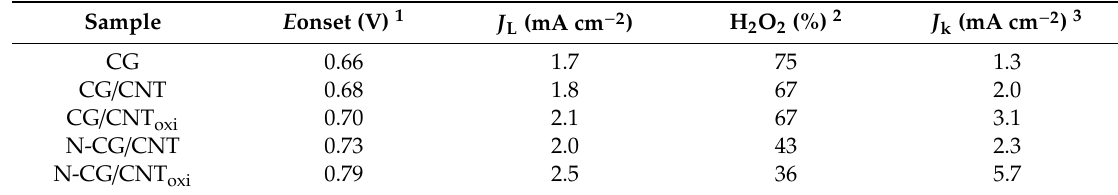
Figure 5. Linear sweep voltammograms (LSV) and the number of electrons transferred measured at 1600 rpm for the carbonized glucose and the undoped and N-doped carbon composites prepared by introducing CNT ( a , c ) and oxidized CNT ( b , d ). Table 3. Electrochemical parameters obtained from linear sweep voltammetry